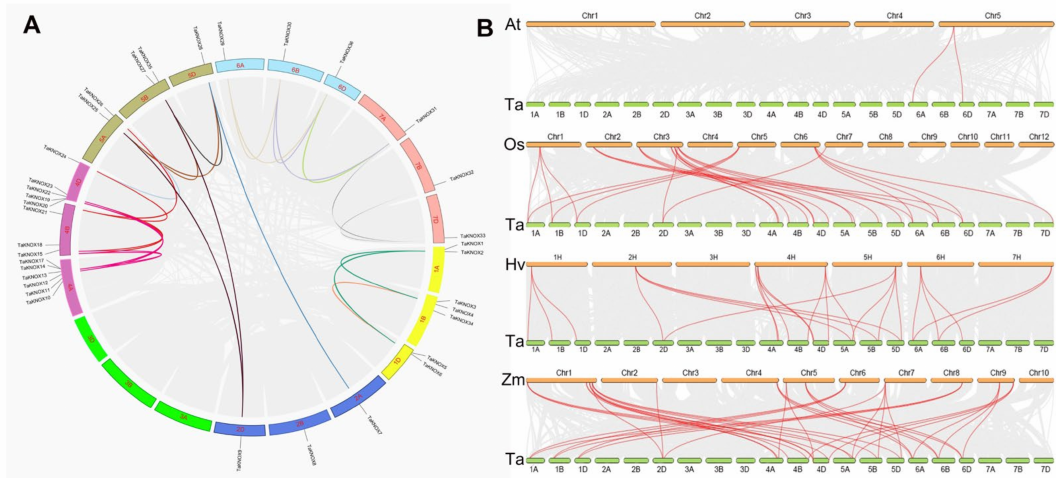
Figure 1. Distribution and duplication events of TaKNOX genes across the wheat genome. ( A ) TaKNOX genes are located at 18 chromosomes, and WGD/segmental and tandem duplica- tions are mapped to their respective locations. The different colored curved frames represent the different chromosomes of wheat. Gray regions indicate all synteny blocks within the wheat genome, other color lines represent WGD/segmental and tandem duplications. The chromosome numbers are marked inside of the circle, each chromosome was represented by different colors. ( B ) Syntenic relationships of wheat KNOX genes among Arabidopsis thaliana , Oryza sativa . Genomic collinearity regions of wheat and other species are indicated by gray lines. The red lines indicate the collinear KNOX gene pairs. Ta: wheat, At: Arabidopsis thaliana , Os: rice, Hv: barley, Zm: